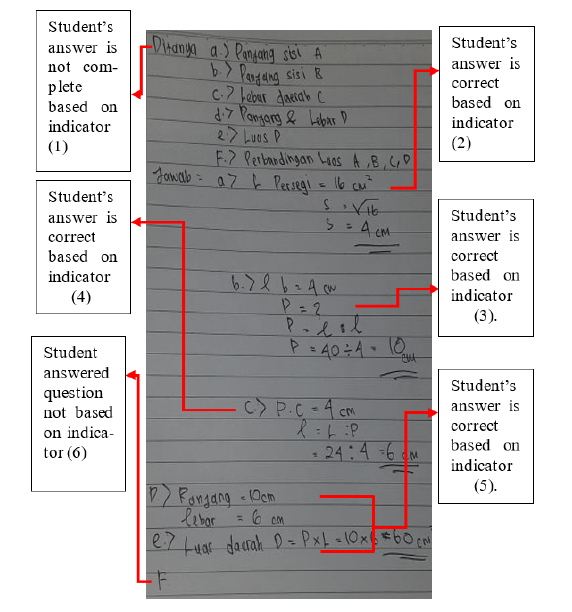
Fig. 4. Pretest answers of the student of the control